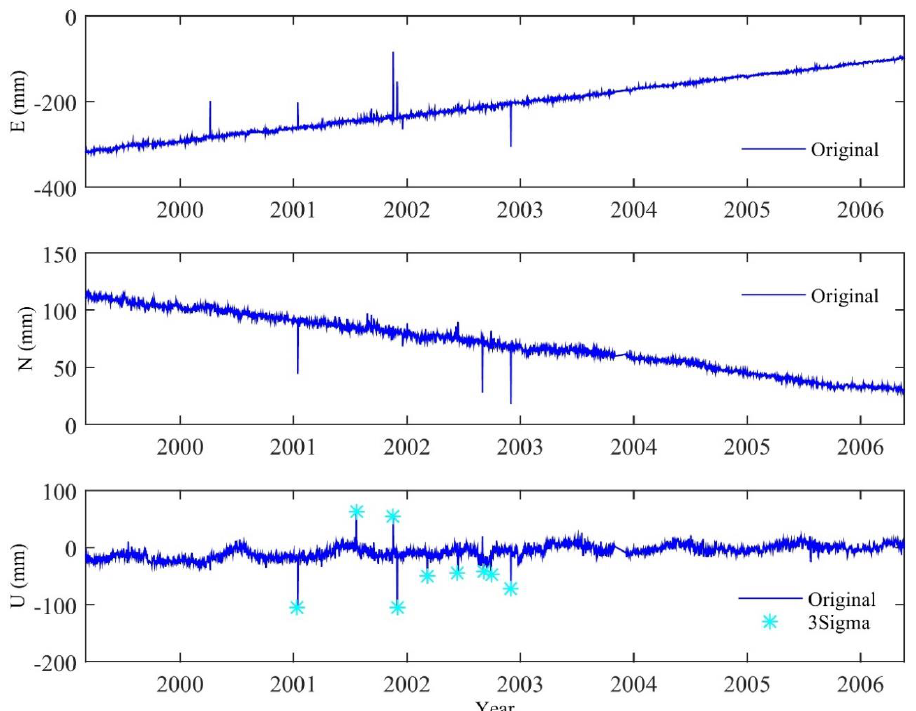
Figure 14. The BJFS station coordinate time series is judged by the 3 IQR rule for gross errors, and blue stars indicate gross errors.